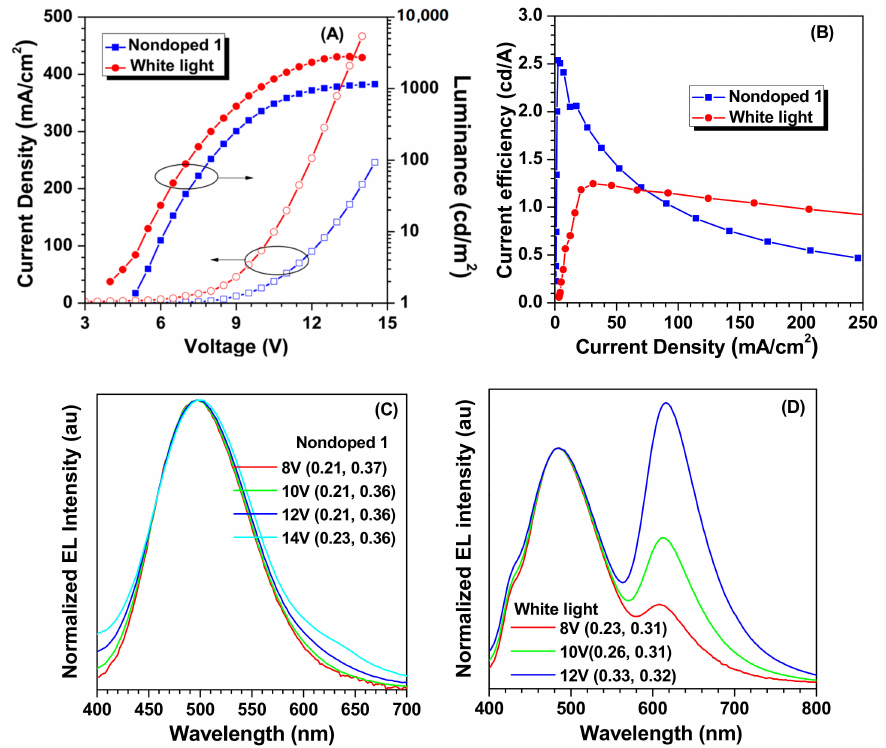
Figure 3. Changes in ( A ) current density and luminance with the applied voltage; ( B ) current efficiency with the current density; ( C ) EL spectra with the voltage in Nondoped 1; ( D ) EL spectra with the voltage in white light device. Device configuration: Nondoped 1: ITO/PEDOT:PSS (30 nm)/Poly-TPD (30 nm)/TPE-4Py (30 nm)/TPBi (50 nm)/Liq (1 nm)/Al (100 nm); white light: ITO/PEDOT:PSS (30 nm)/Poly-TPD (30 nm)/mCP:OXD-7:TPE-4Py (70:20:10, 30 nm)/TPBi (50 nm)/Liq (1 nm)/Al (100